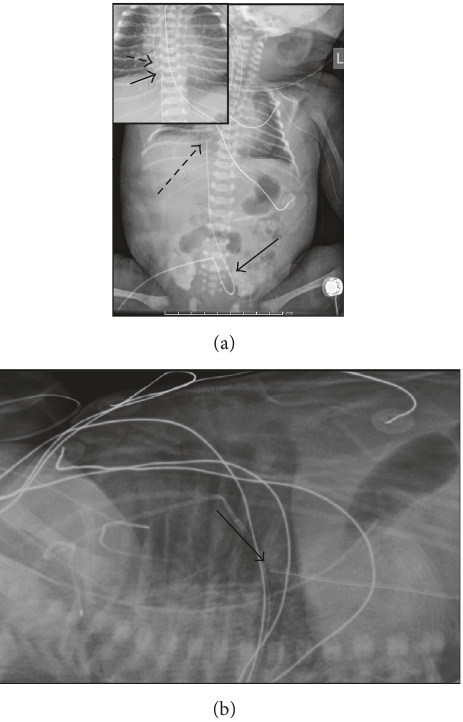
Figure 1: Anterior-posterior portable radiographs (a) and cross- table lateral radiograph (b) demonstrating the abnormal course of the umbilical catheter. The anterior-posterior view illustrates the caudal loop (solid arrow) as well as the superior ascent of the umbilical catheter to the right atrium (dashed arrow). The inset image of a subsequent anterior-posterior image reveals the close proximity of the umbilical catheter (solid arrow) and the peripherally inserted central venous catheter placed (dashed arrow) in the arm. The lateral radiograph reveals the position of the umbilical catheter (solid arrow) anterior to the expected position of the aorta.